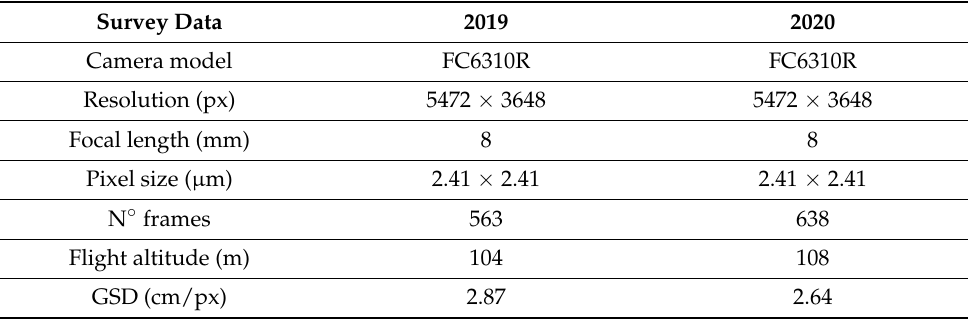
Table 1. Summary of the key parameters of the available UAV photogrammetric